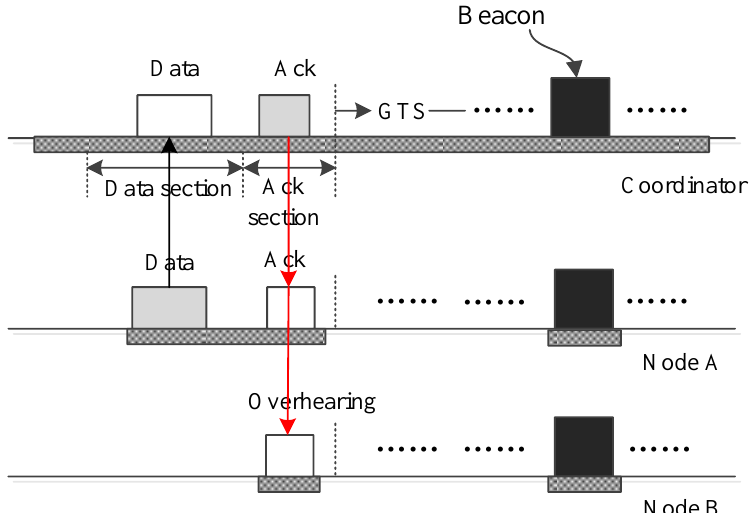
Figure 6. Only one node sends small data to the